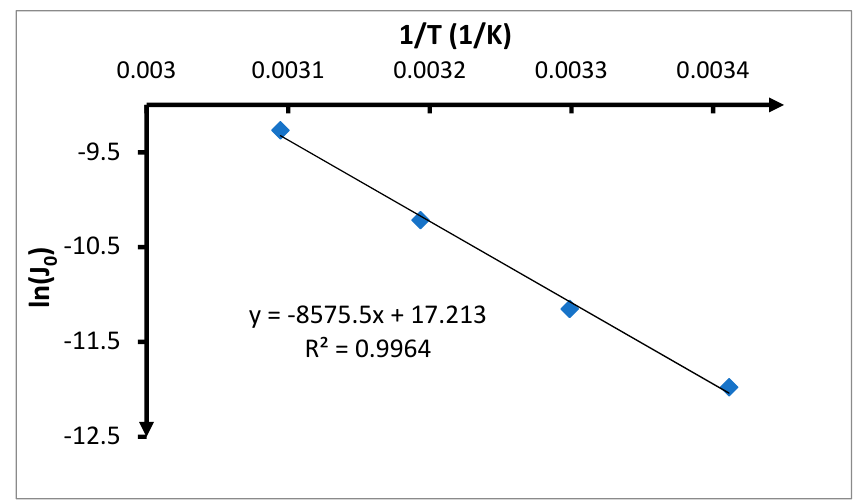
Figure 14. Graphical representation of the Eyring equation. The volumetric flow rate is 3.0 cm 3 / min. Feeding phase: CuCl 2 concentration—0.1 mol / dm 3 , chloride concentration-2.0 mol / dm 3 . Receiving phase: demineralized water. Membrane: CTA-ONPOE-TRIA-10. The composition of the membrane is provided in Table 2.